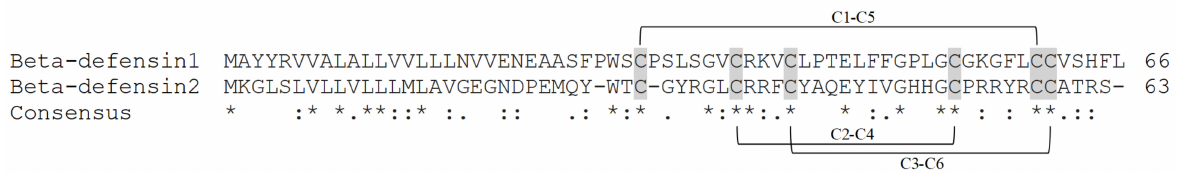
Figure 2. Alignment of sea bass beta-defensins. Cysteines are shaded gray, and the predicted disulphide bridges are also shown. Identical residues are denoted by (*), conserved substitutions by (:) and semi-conserved substitutions by